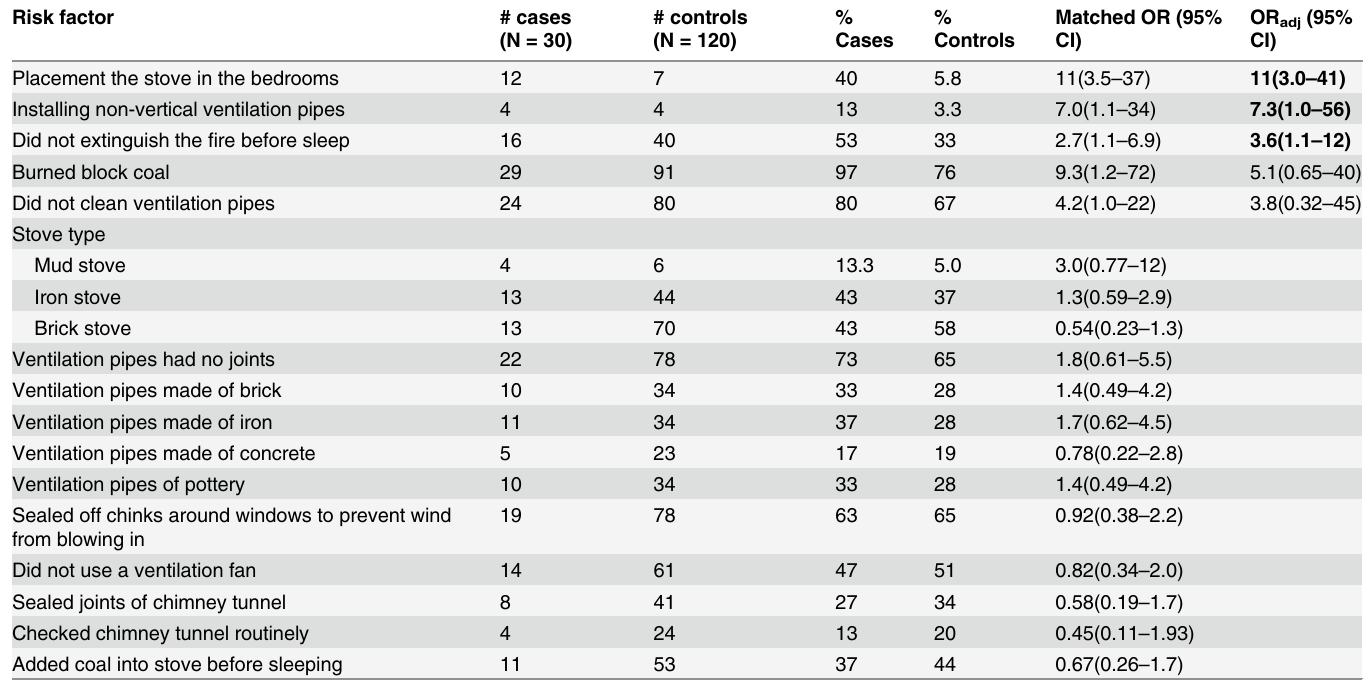
Table 2. Risk factors for non-occupational CO poisoning: Anshan Prefecture, Liaoning Province, China, October 1, 2010, to February 28,